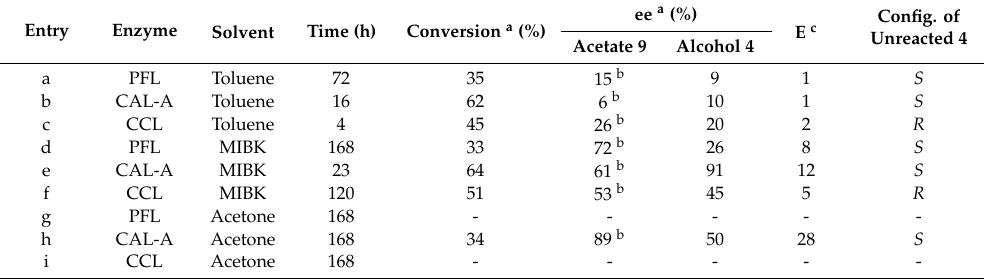
Table 3. Enzyme-catalyzed irreversible transesterification of rac - 4 in toluene, methyl isobutyl ketone (MIBK) and acetone.